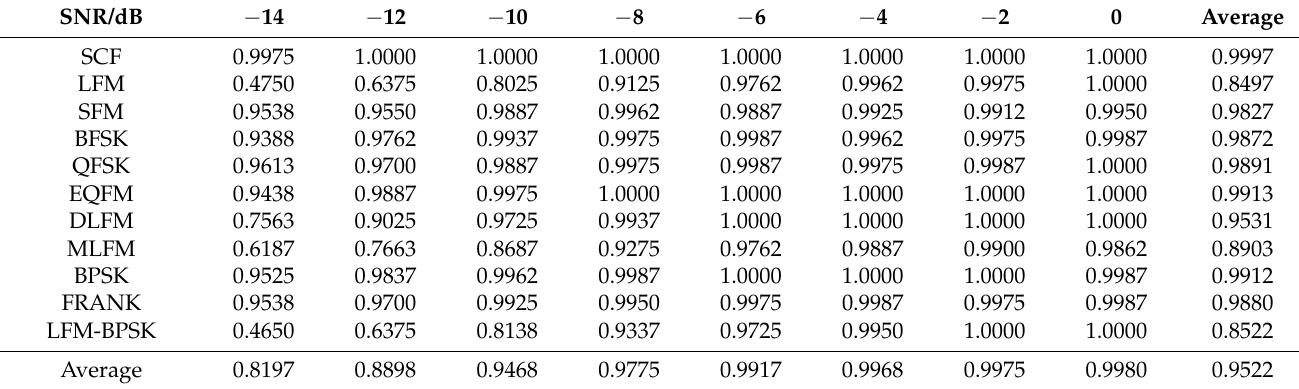
Table 2. The classification accuracy of eleven intra-pulse modulations based on 1-D